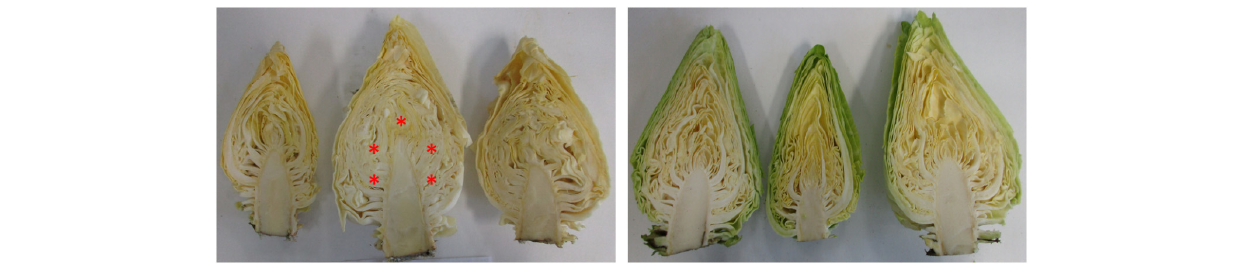
FIGURE 4 | Internal quality development of pointed cabbages stored for 6 months under normal air (left) or 1 kPa O 2 + 5 kPa CO 2 (right). Every cabbage was measured five times on the center parts avoiding the main vein as indicated by the red asterisk ( ∗ ). The values were averaged to obtain the mean value for each cabbage